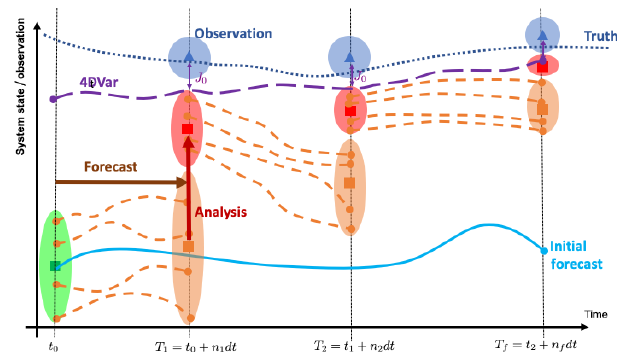
Figure 1. Principle of data assimilation (adapted from Carrassi et al., 2018). Having a physical model able to forecast the evolu- tion of a system from time t = t 0 to time t = T f (cyan curve), the aim of DA is to use available observations (blue triangles) to correct the model projections and get closer to the (unknown) truth (dotted line). In EnKFs, the initial system state and its uncertainty (green square and ellipsoid) are represented by N e members. The mem- bers are propagated forward in time during n 1 model time steps d t to t = T 1 where observations are available (forecast phase, orange dashed lines). At T = t 1 the analysis uses the observations and their uncertainty (blue triangle and ellipsoid) to produce a new system state that is closer to the observations and with a lower uncertainty (red square and ellipsoid). A new forecast is issued from the anal- ysed state and this procedure is repeated until the end of the assim- ilation window at t = T f . The model state should get closer to the truth and with lower uncertainty as more observations are assimi- lated. Time-dependent variational methods (4D-Var) iterate over the assimilation window to find the trajectory that minimises the misfit ( J 0 ) between the model and all observations available from t 0 to T f (violet curve). For linear dynamics, Gaussian errors and infinite ensemble sizes, the states produced at the end of the assimilation window by the two methods should be equivalent (Li and Navon,